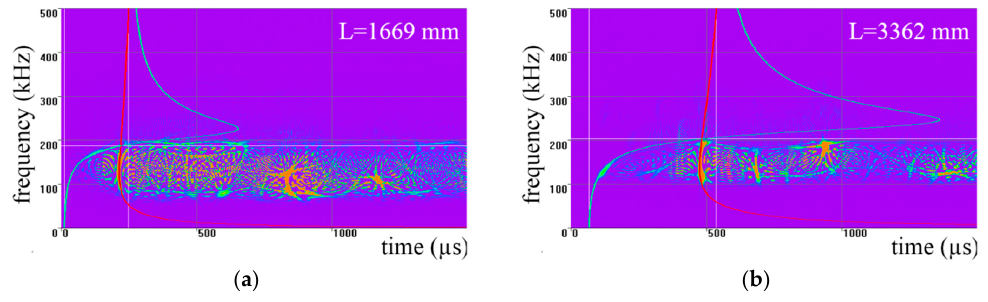
Figure 28 . Dispersion curves for channel 29 ( a ); and for channel 30 ( b ). Figure 28. Dispersion curves for channel 29 ( a ); and for channel 30 ( b